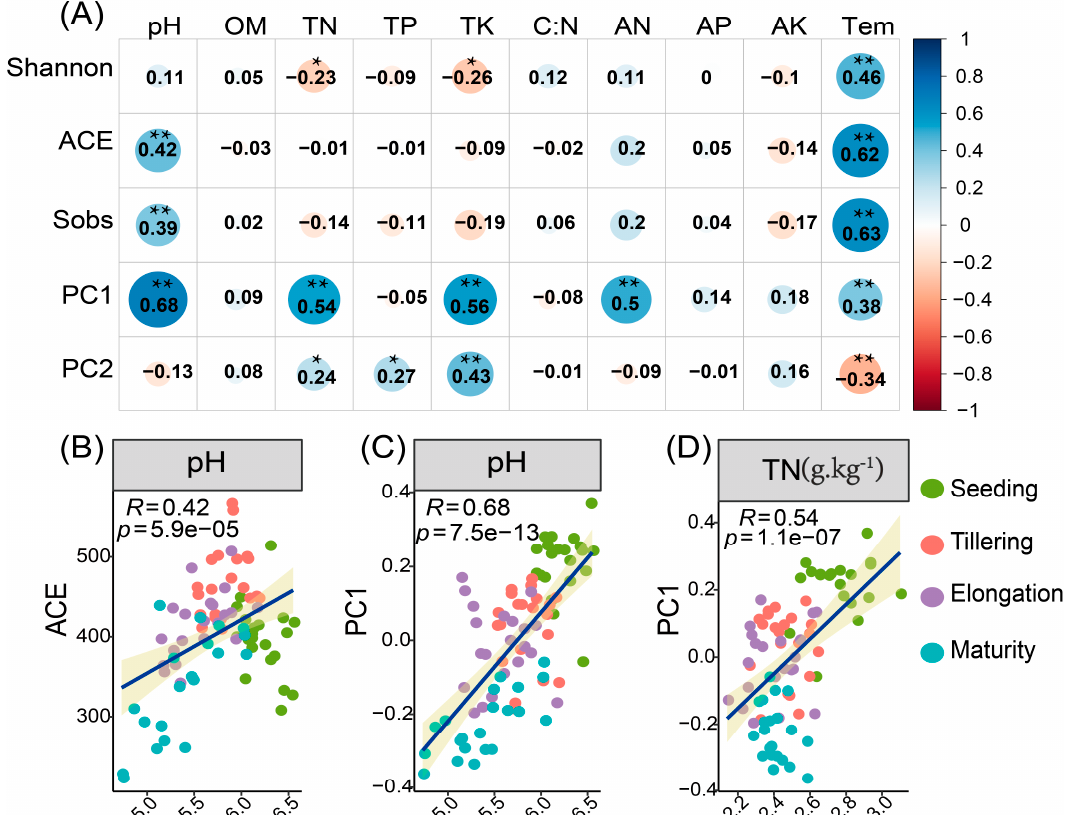
Figure 2. Pearson’s correlation coe ffi cients for soil physio − chemical properties and fungal alpha diversity, PC1 and PC2 ( A ), and regressions analysis among soil environmental variables, fungal ACE (richness) and PC1 sampled during the stage of Seeding, Tillering, Elongation and Maturity, pH and ACE ( B ), pH and PC1 ( C ), TN and PC1 ( D ). * p < 0.05, ** p < 0.01.